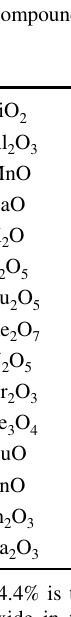
Table 1 XRF result of the synthesized magnetite